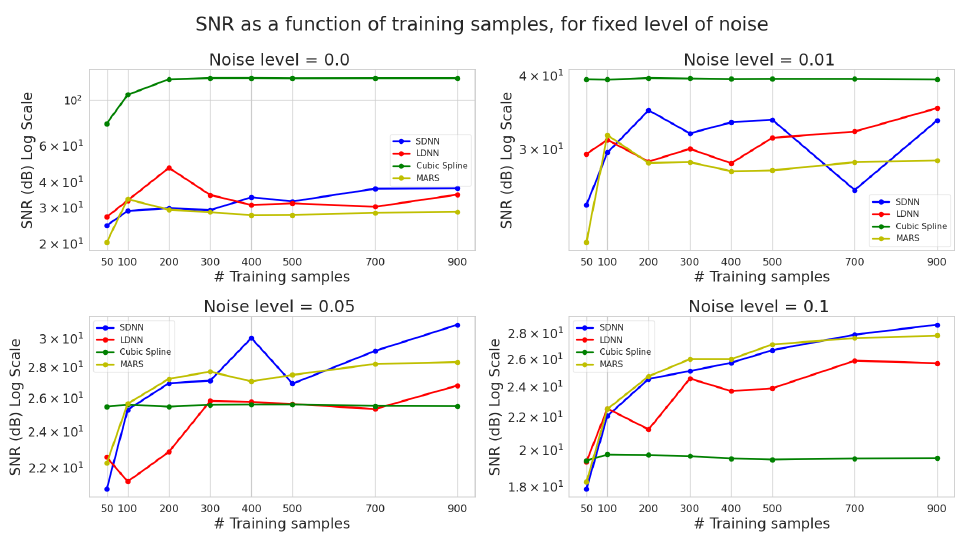
Figure 8. SNR vs. the total number of training samples for four different noise levels. The aver- age values over five runs are presented. Blue colour represents SDNN, green cubic splines, and yellow